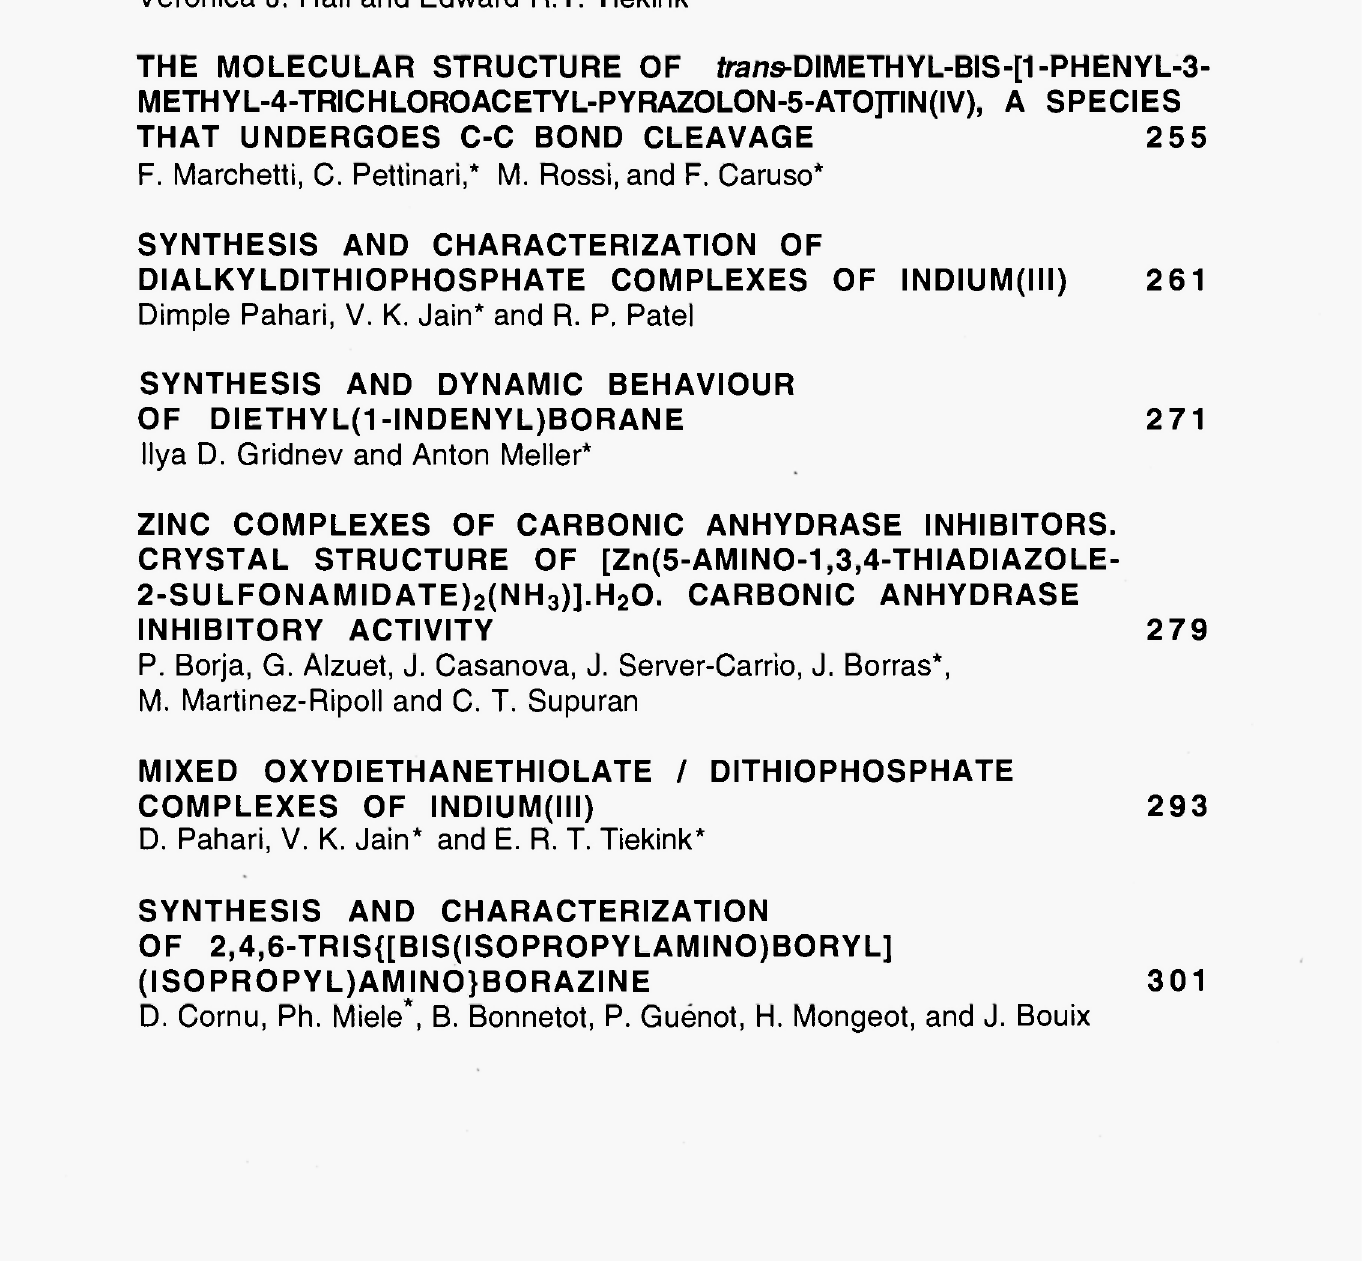
OF THE IMPORTANCE OF VARYING THE LEWIS ACIDITY OF R IN DETERMINING THE MOLECULAR STRUCTURE OF R Sn(1,1-DITHIOLATE) COMPOUNDS: THE CRYSTAL AND 2 MOLECULAR STRUCTURES OF THREE DIVINYLTIN N,N-DIALKYLDITHIOCARBAMATES 2